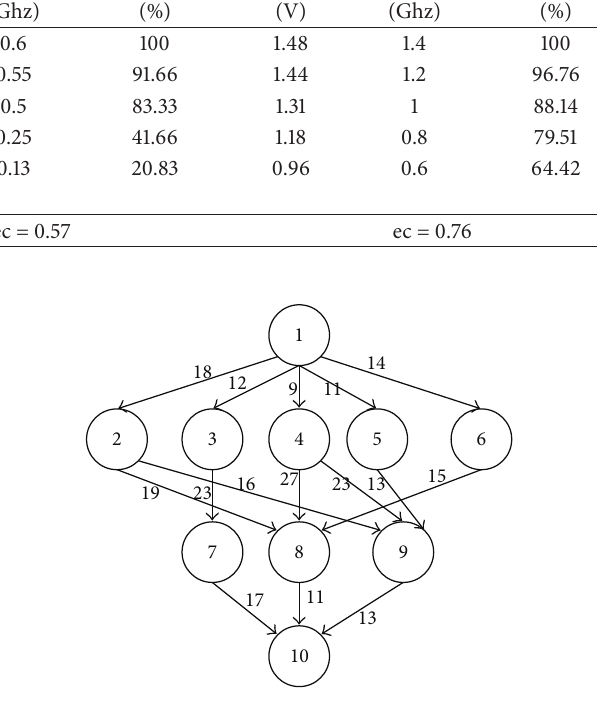
Figure 1: An example of workflow (given in [17]) with the task numbers 𝑇 𝑖 inside nodes and values of 𝑑 𝑖𝑗 function next to the corresponding